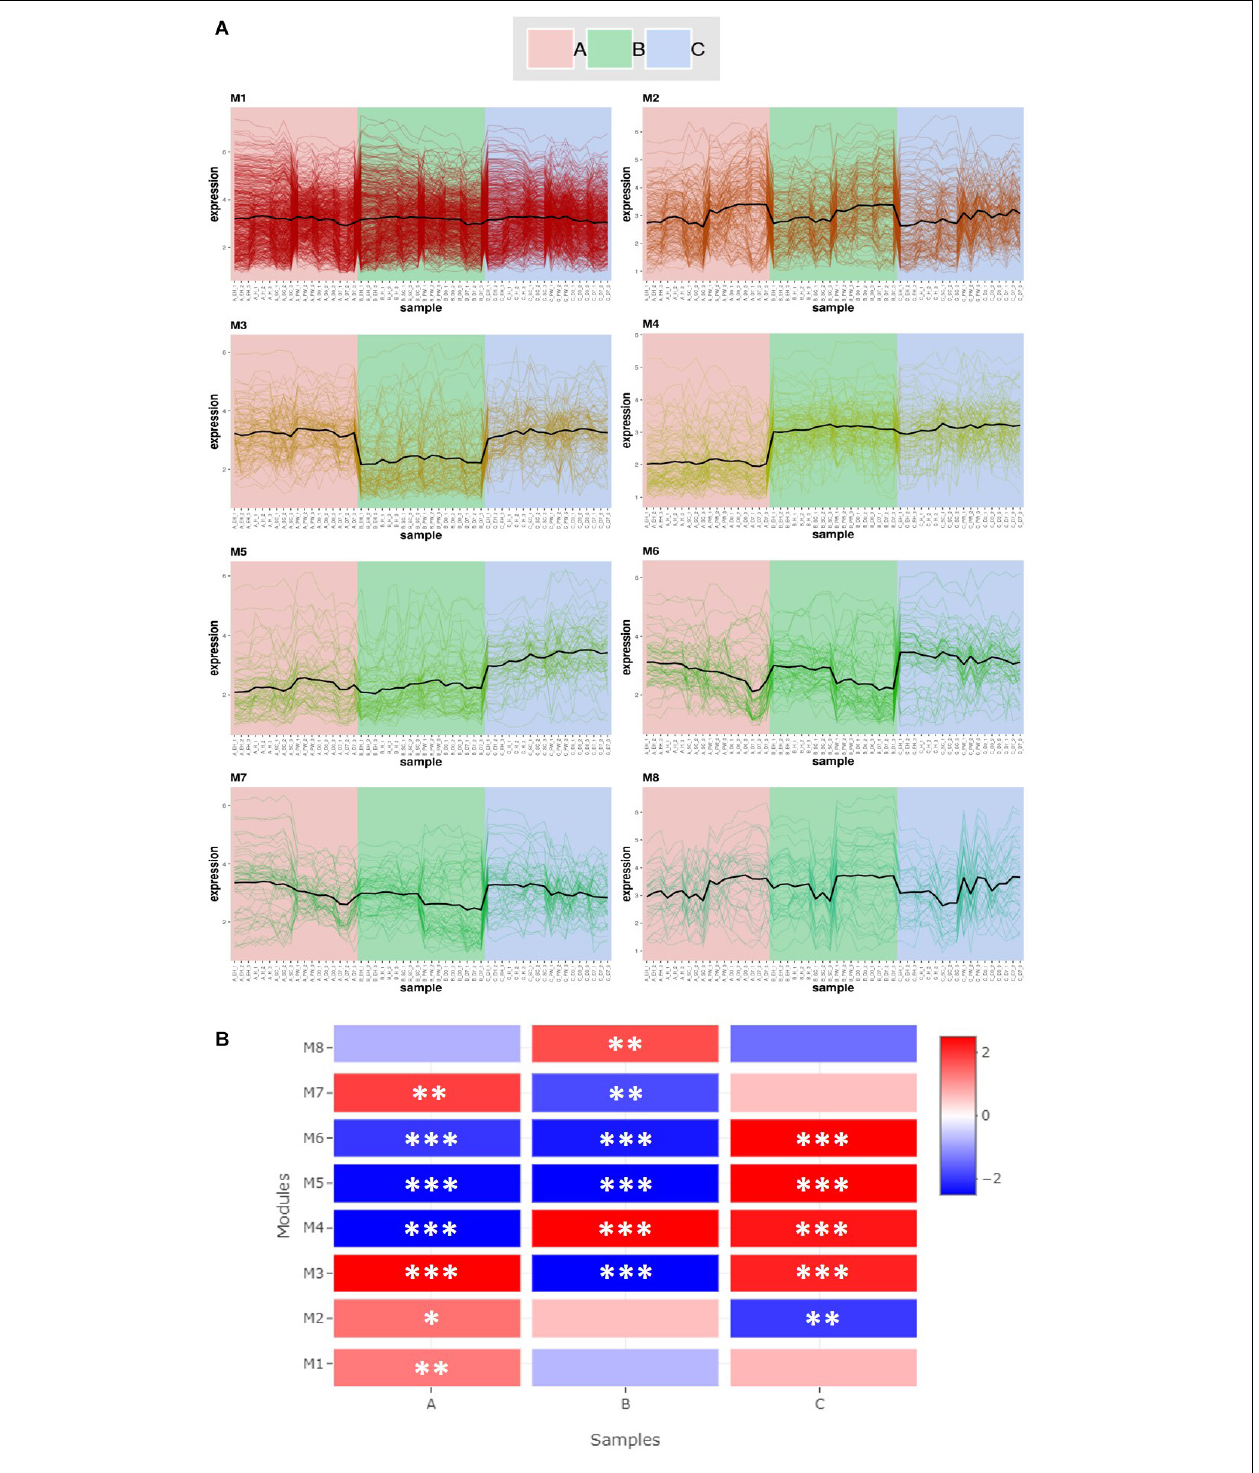
FIGURE 4 | Co-expression module analysis (A) and Gene Set Enrichment Analysis (GSEA; (B) of three elite inbred lines of Eruca sativa . Eight gene modules (M1–M8) were identified within the transcriptomes of lines A , B , and C (see inset for color coding). Modules contain 583 ( M1 ), 184 ( M2 ), 112 ( M3 ), 107 ( M4 ), 72 ( M5 ), 65 ( M6 ), 58 ( M7 ), and 38 ( M8 ) genes, respectively (A) . The heat-map (B) illustrates differences in module activity (red, high; blue, low) between each genotype, and asterisks indicate the level of Normalized Enrichment Score (NES) significance: * p ≤ 0.05; ** p ≤ 0.01; *** p ≤ 0.001. Complete gene lists for each module and the corresponding enrichment analysis statistics are presented in Supplementary Data File 2